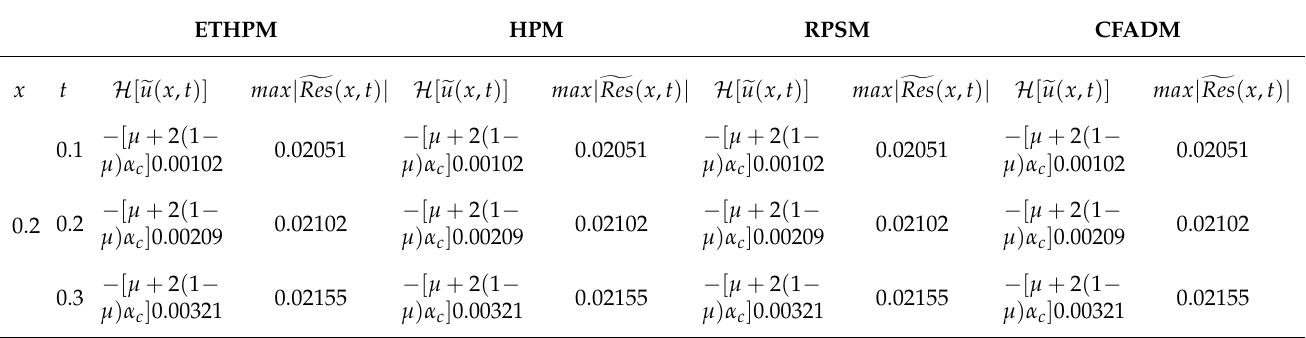
Table 9. H [ (cid:101) u ( x , t )] and max | (cid:103) Res ( x , t ) | by ETHPM, HPM, RPSM, CFADM for α = 1, τ = 0.2, r = 0.25, A = 1, B =